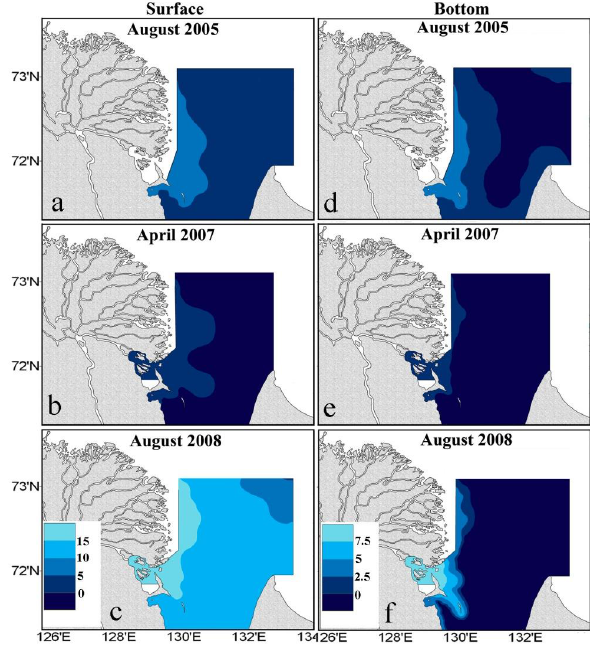
Fig. 5. Temperature of the surface and bottom BKB water layers in 2005, 2007, and 2008. Temperature levels ( ◦ C) are shown as col- ored rectangles in (c) and (f)